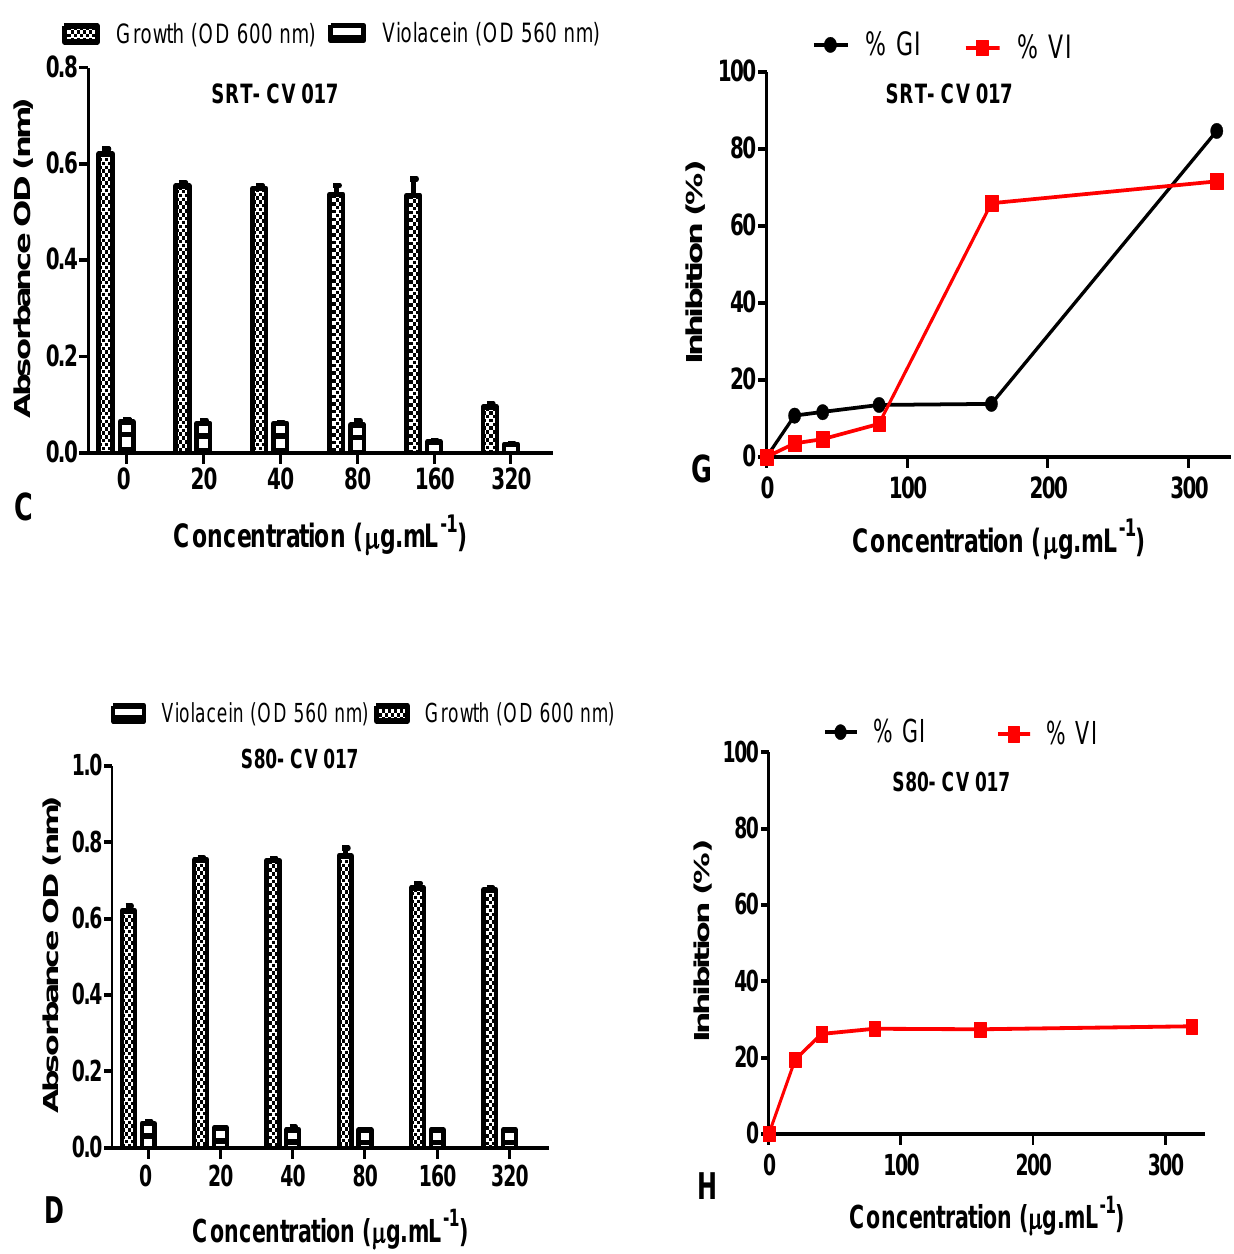
Figure 11. Quantitative analysis of the inhibitory effect of different concentrations of D. villosa leaves and stem bark AgNPs synthesized at both room temperature (RT) and at 80 ◦ C on production of violacein by Chromobacterium subtsugae CV017. Cultures were grown in the presence of 0–320 µ g/mL of respective leaves and stem bark AgNPs synthesized at RT and 80 ◦ C. Frames ( A – D ) represent growth (OD 600 nm) and violacein inhibition (OD 560 nm) following nanoparticle treatment, while frames ( E – H ) represent %growth (%GI) and % violacein (%VI) inhibition. Data represent the average of triplicate independent experiments and SD. The QS inhibition of the leaves AgNPs synthesized at both RT and 80 ◦ C were quan- tified using C. violaceum ATCC 12472 as the indicator biosensor (Figure 12). The %GI and %VI of D. villosa LRT against ATCC 12472 was <50% at 20–160 µ g/mL (Figure 12C), however, at 320 µ g/mL, the %GI and %VI of LRT against C. violaceum ATCC 12472 was 29.07% and 56.53% (Figure 12C). The %GI and %VI of L80 nanoparticles against C.